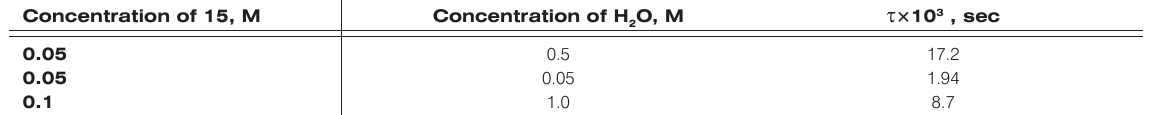
Table 3. The temperature dependence of mean life time τ for system 15 + 10 M H T, K τ ×10 3 , sec